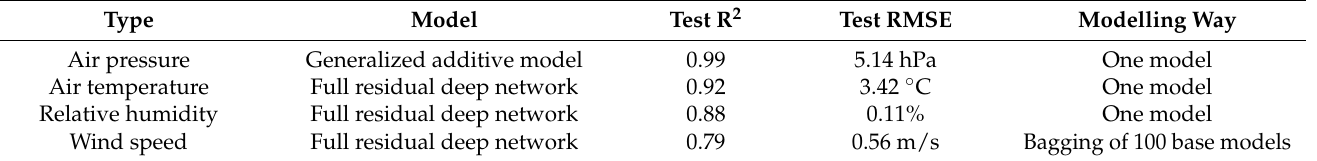
Table 3. Test performance of the fusion of high-resolution meteorological variables.